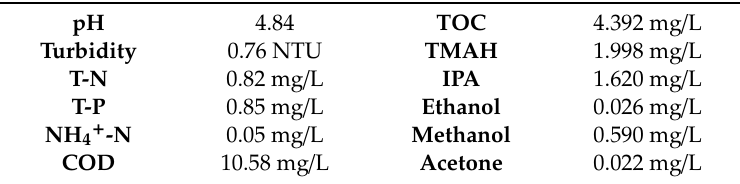
Table 2. Characteristics of low-strength electronics